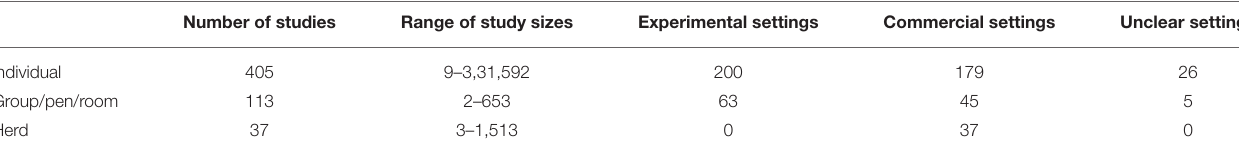
TABLE 5 | Study size a of clinical trials and observational studies at the hierarchical level of the data analysis. Number of studies Range of study sizes Experimental settings Commercial settings Unclear